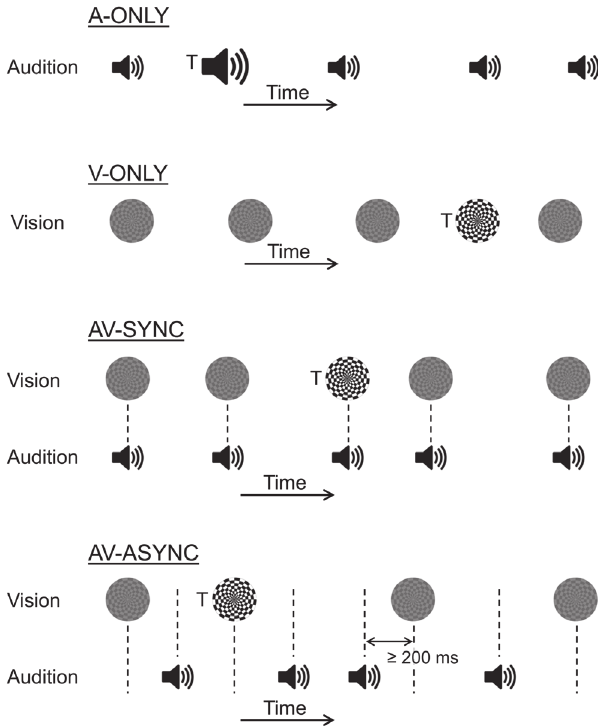
Fig 1. Schematic Representation of Stimulus Timing in Each Stimulation Condition. The exact timing of events was in all cases arrhythmic and unpredictable. Events marked with a “ T ” represent higher-intensity (A-ONLY condition) or higher-contrast (V-ONLY, AV-SYNC, and AV-ASYNC) targets, which occurred every 2 – 5 s. In the AV-ASYNC condition, onsets between adjacent auditory and visual events were separated by a minimum of 200